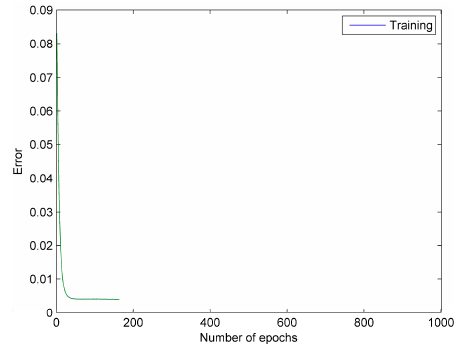
Figure 3. The error curve of FSGD. The green line represents the training error of each epoch.